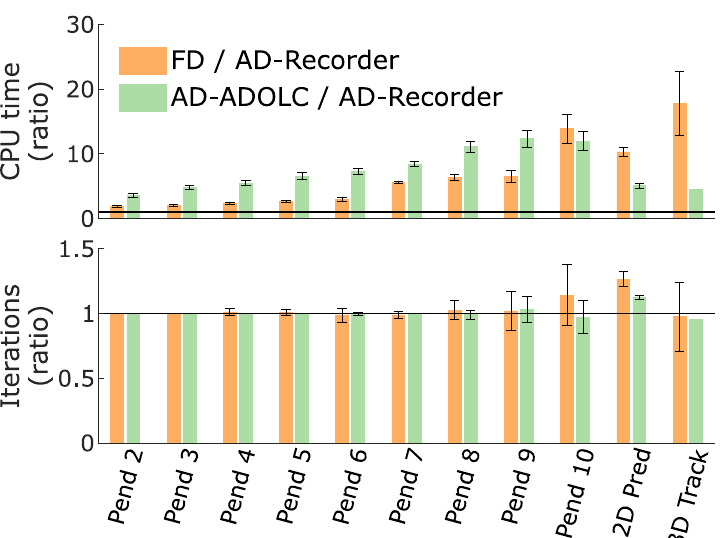
Fig 3. Comparison of computational time (top) and number of iterations (bottom) between FD, AD-ADOLC, and AD-Recorder. The comparisons are expressed as ratios and averaged over results from different initial guesses (error bars represent ± one standard deviation). The horizontal lines indicate 1:1 ratios. Ratios larger than one indicate slower convergence (top) and more iterations (bottom) with FD or AD-ADOLC as compared to AD-Recorder. Pend indicates pendulum simulations with the number being the number of degrees of freedom; Pred and Track indicate predictive and tracking simulations, respectively. The results were obtained using mumps and an approximated Hessian.